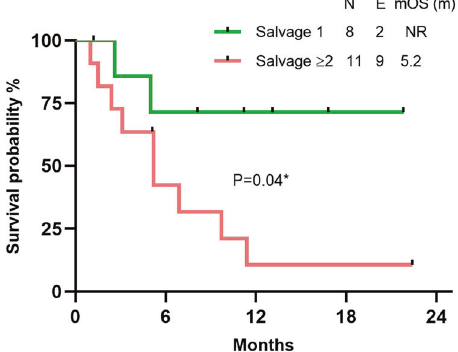
Fig. 2 Kaplan – Meier plot showing overall survival (OS) by line of therapy in R/R cohort. N number, E events,mOS (m) median overall survival in